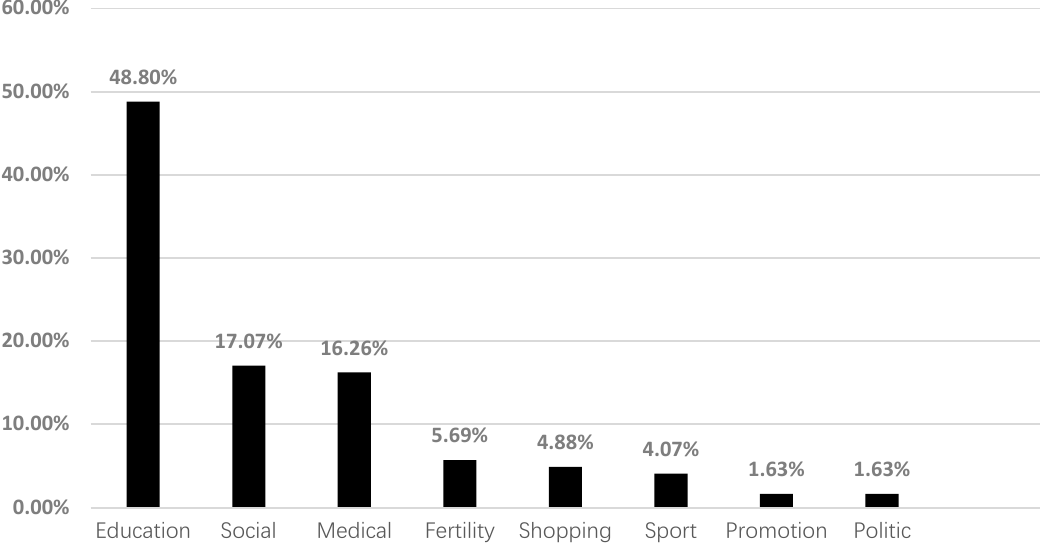
Figure 1. the respondents’ concerns about GD in other circumstances. Figure 1. The respondents’ concerns about GD in other